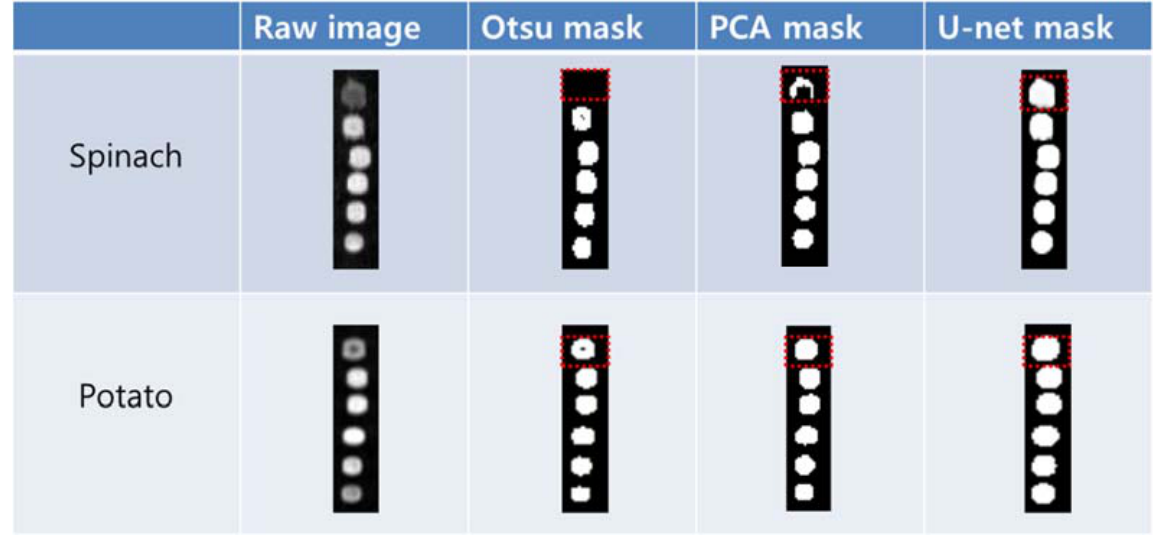
Figure 3. Target segmentation results of the spinach and potato residue droplets. The mask generated by U-net had less loss of the target image pixels.